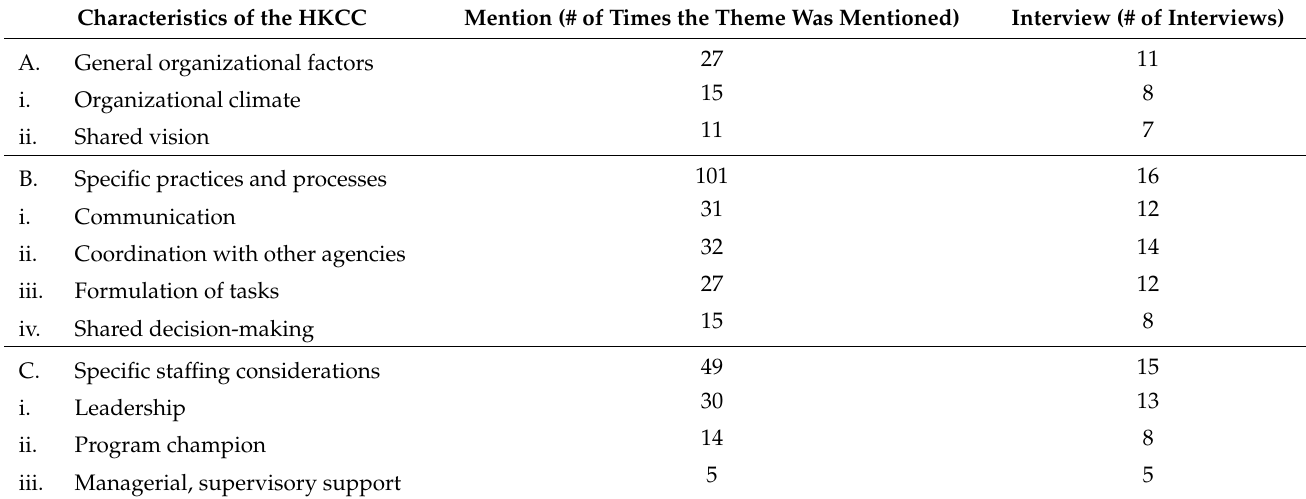
Table 3. Factors related to organizational capacity, as reported by interview